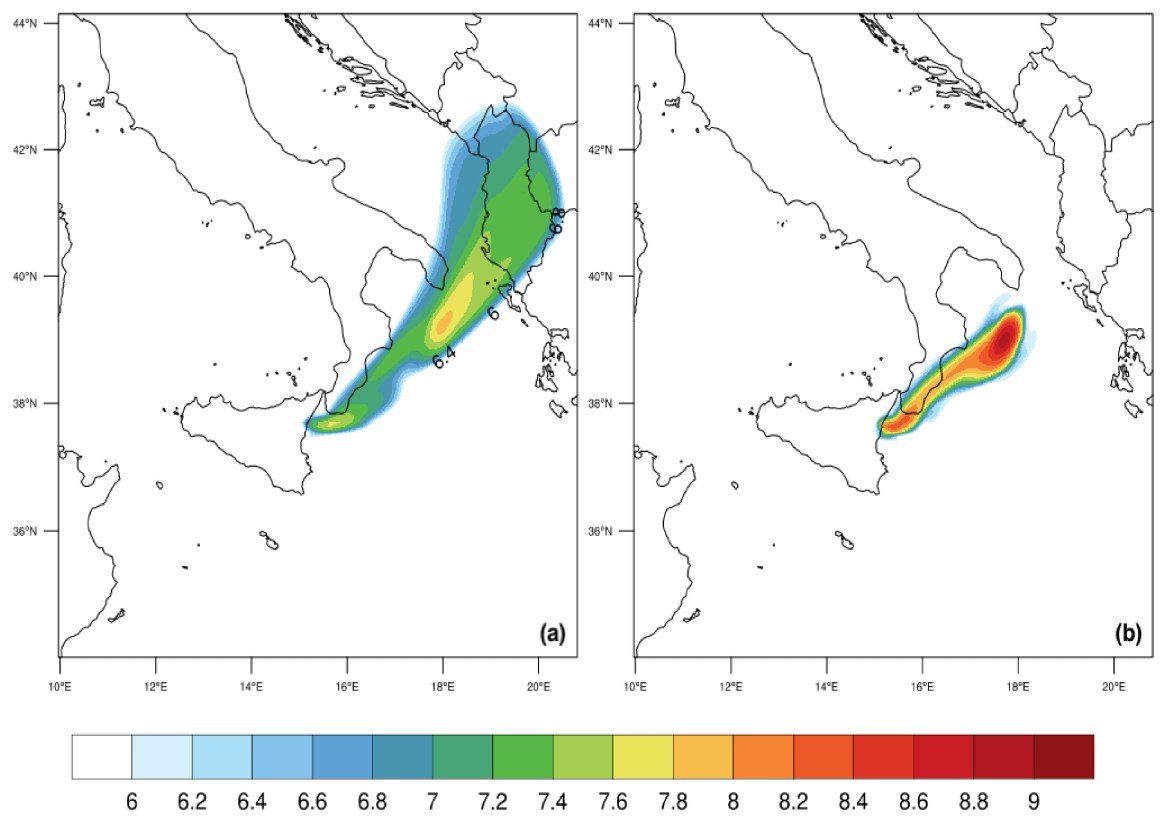
Figure 10. The columnar quantity ( Vash col , µ g m − 2 ), in log 10 scale, for ( a ) run1 and ( b ) run2 configurations, both at 12:00 UTC on 23 November